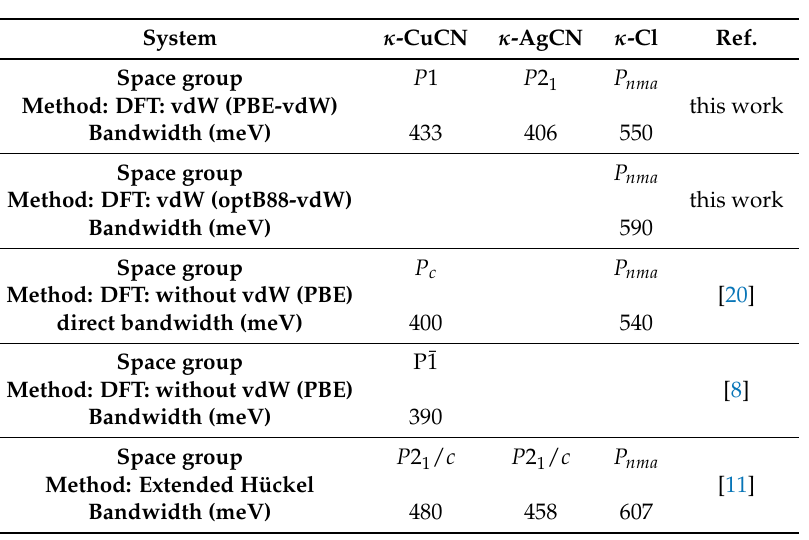
Bandwidth (meV) 480 458